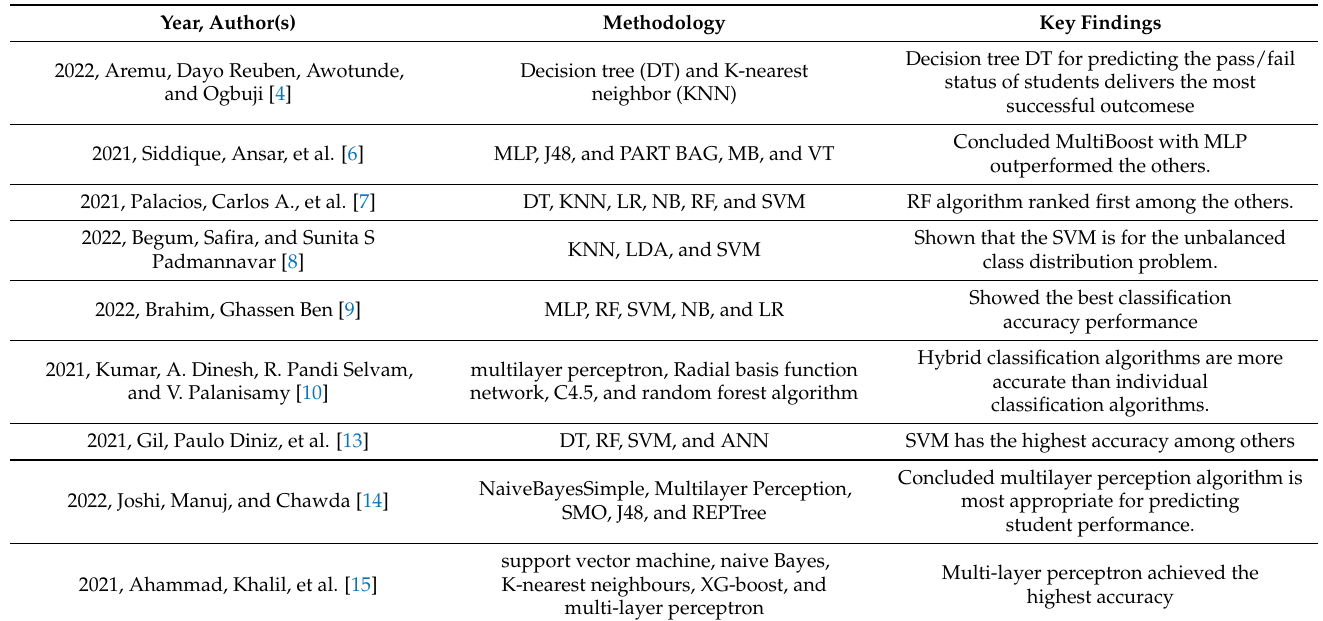
Table 1. Comparison of data mining techniques in predicting student’s